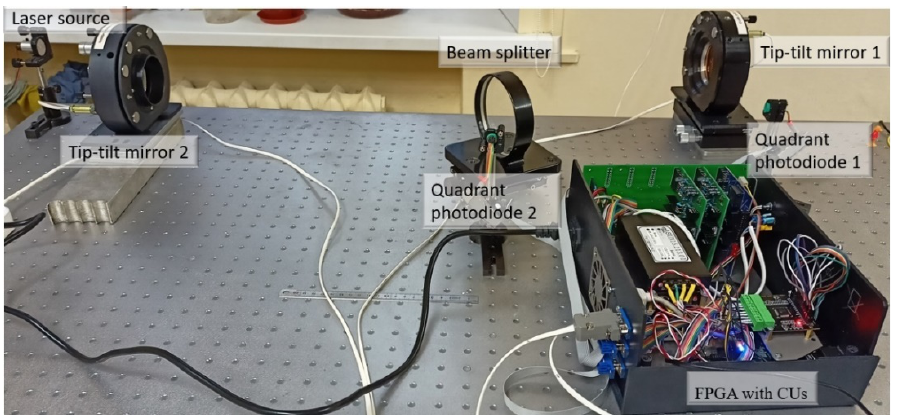
Figure 11. Photo of the testbed.